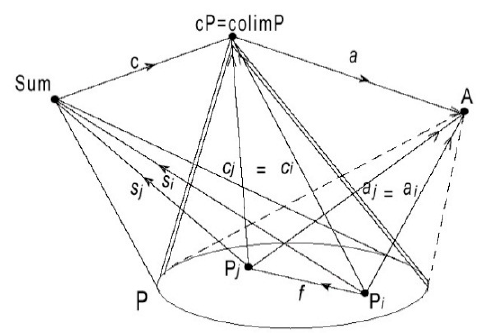
Figure 1. A pattern P, the colimit cP of P and the sum S of the family of objects of P. The colimit cone (c i ) from P to cP binds into the comparison morphism c from S to